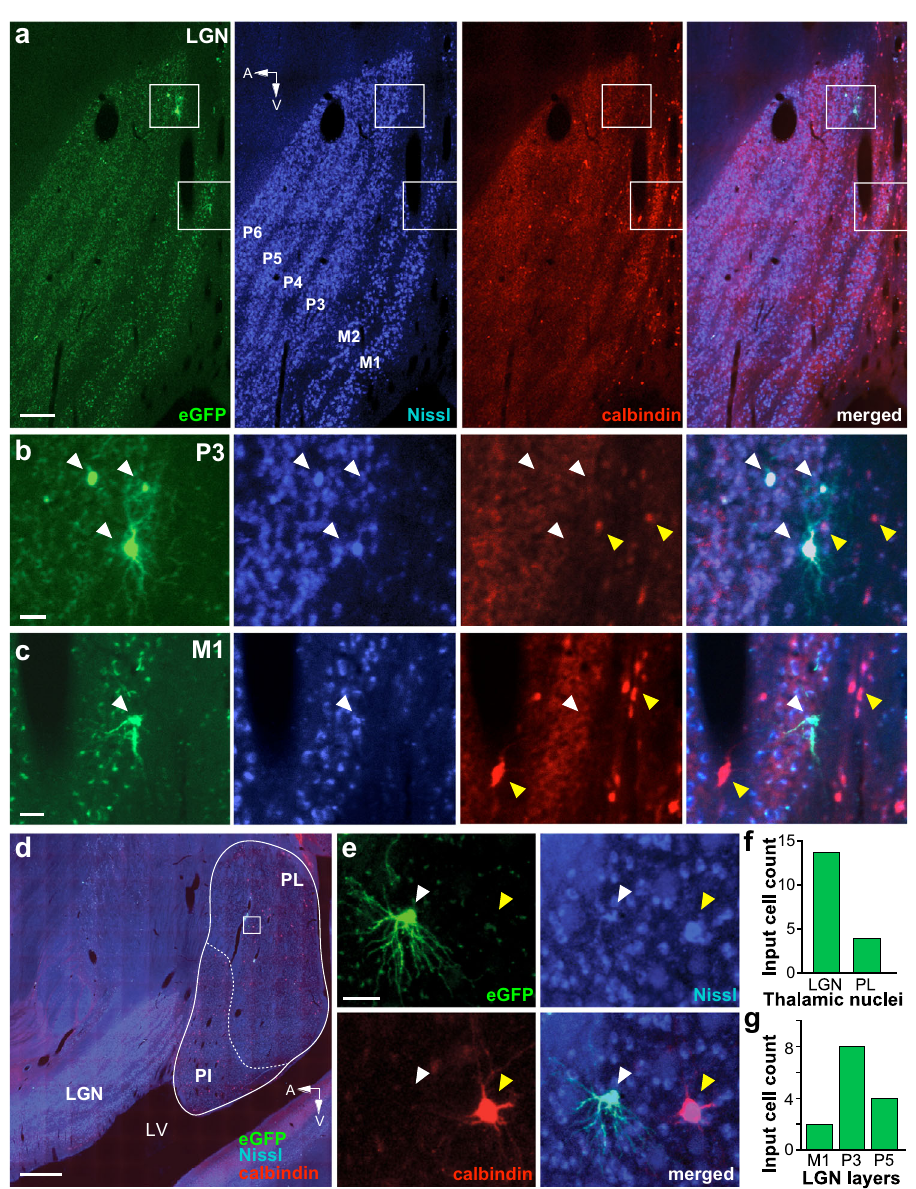
Fig. 8 Thalamic input cells. a Case MK379. Image of a single parasagittal section through the LGN viewed under GFP fl uorescence (Left), stained for fl uorescent Nissl (Middle Left), immunostained for Calbindin-Alexa647 (Middle Right), and with all three channels merged (Right). The GFP-labeled cells inside the top and bottom white boxes are shown at higher magni fi cation in ( b , c ), respectively. The parvocellular (P3 – 6) and magnocellular (M1 – 2) LGN layers are labeled. A: anterior; V: ventral. Scale bar: 250 µ m. b , c GFP-labeled LGN input cells in the P3 ( b ) and M1 ( c ) layers are shown in the same three channels as the top panels and with all channels merged (Right). White arrowheads point to the location of GFP-labeled neurons, yellow arrowheads point to calbindin-positive cells. The GFP-labeled cells are not calbindin-positive. Scale bars: 50 µ m. d Image of a sagittal section through the LGN and pulvinar, with all three fl uorescent channels (GFP, calbindin, and Nissl) merged. The cells inside the white box are shown at higher magni fi cation in ( e ). PL lateral pulvinar, PI inferior pulvinar, LV lateral ventricle. Scale bar: 1 mm. e A GFP-labeled input cell (white arrowhead) in the PL imaged under the same three channels as for the LGN cells and with all channels merged (Bottom Right). A yellow arrowhead in each panel points to the location of a calbindin-positive cell (red). The GFP-labeled cell is not calbindin-positive. Scale bar: 50 µ m. f Number of GFP-labeled cells in the thalamic nuclei. g Number of GFP-labeled cells in the LGN